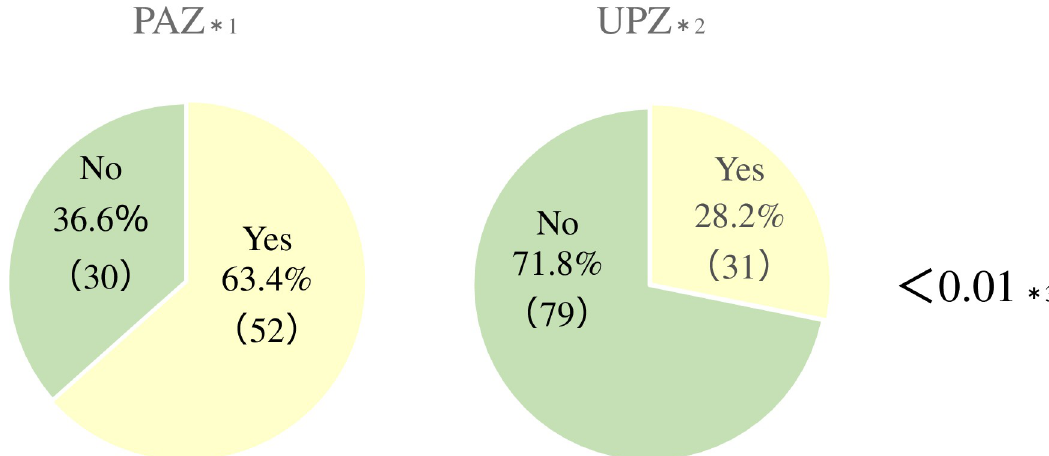
Fig 3. Frequencies of residents in the PAZ and UPZ who received PDSI. � 1. Number who were aware of SI in the PAZ, � 2. Number who were aware of SI in the UPZ, � 3. Chi-square test for the PAZ and UPZ. PAZ = Precautionary Action Zone,